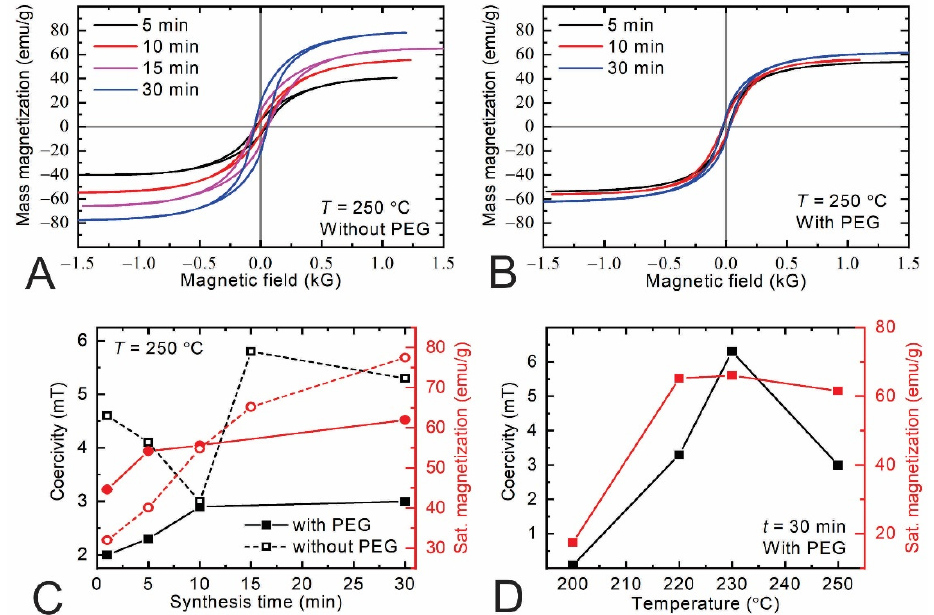
Figure 8. Hysteresis loop of the samples synthesized without PEG at 250 °C for different synthesis times—5, 10, 15 and 30 min—( A ) and that of the samples synthesized with PEG ( B ). Magnetization (black symbols) and coercivity (red symbols) of the samples synthesized with PEG (solid symbols) and without PEG (empty symbols) using different times, from 1 to 30 min at 250 °C ( C ). Saturation magnetization (red symbols) and coercivity (black symbols) of the samples synthesized with PEG at different temperatures ( D ).